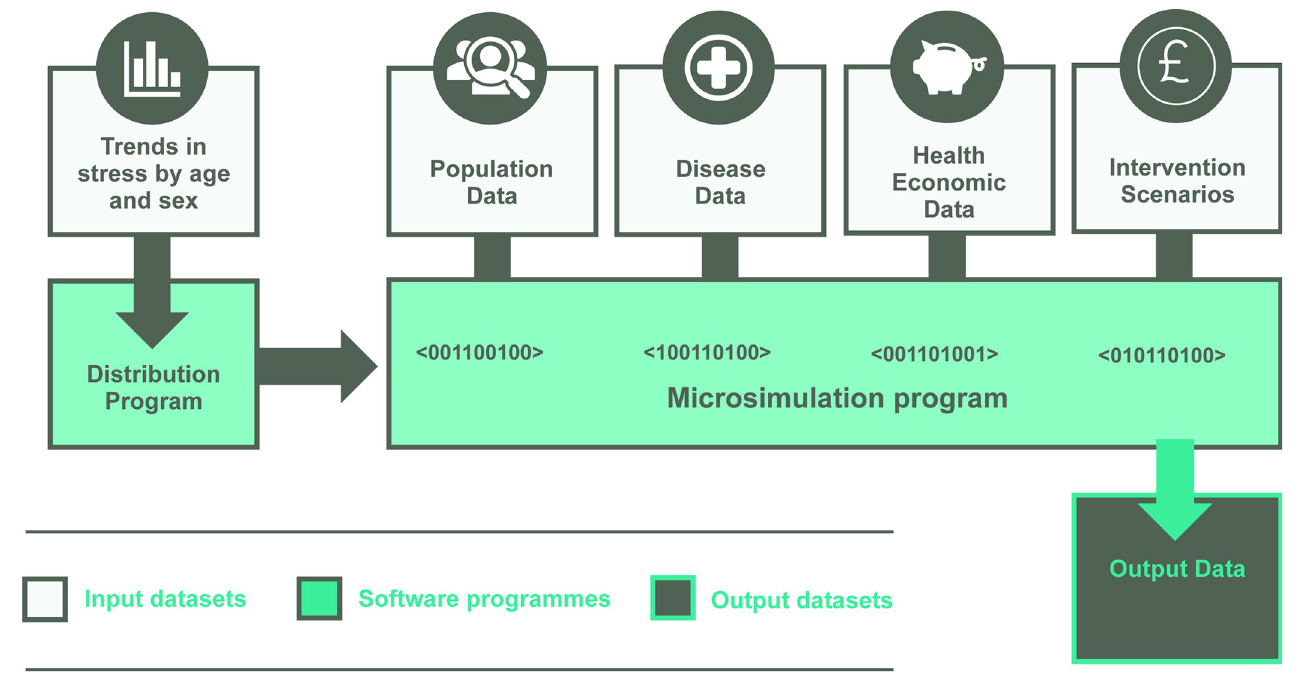
Fig 1. Overview of the microsimulation